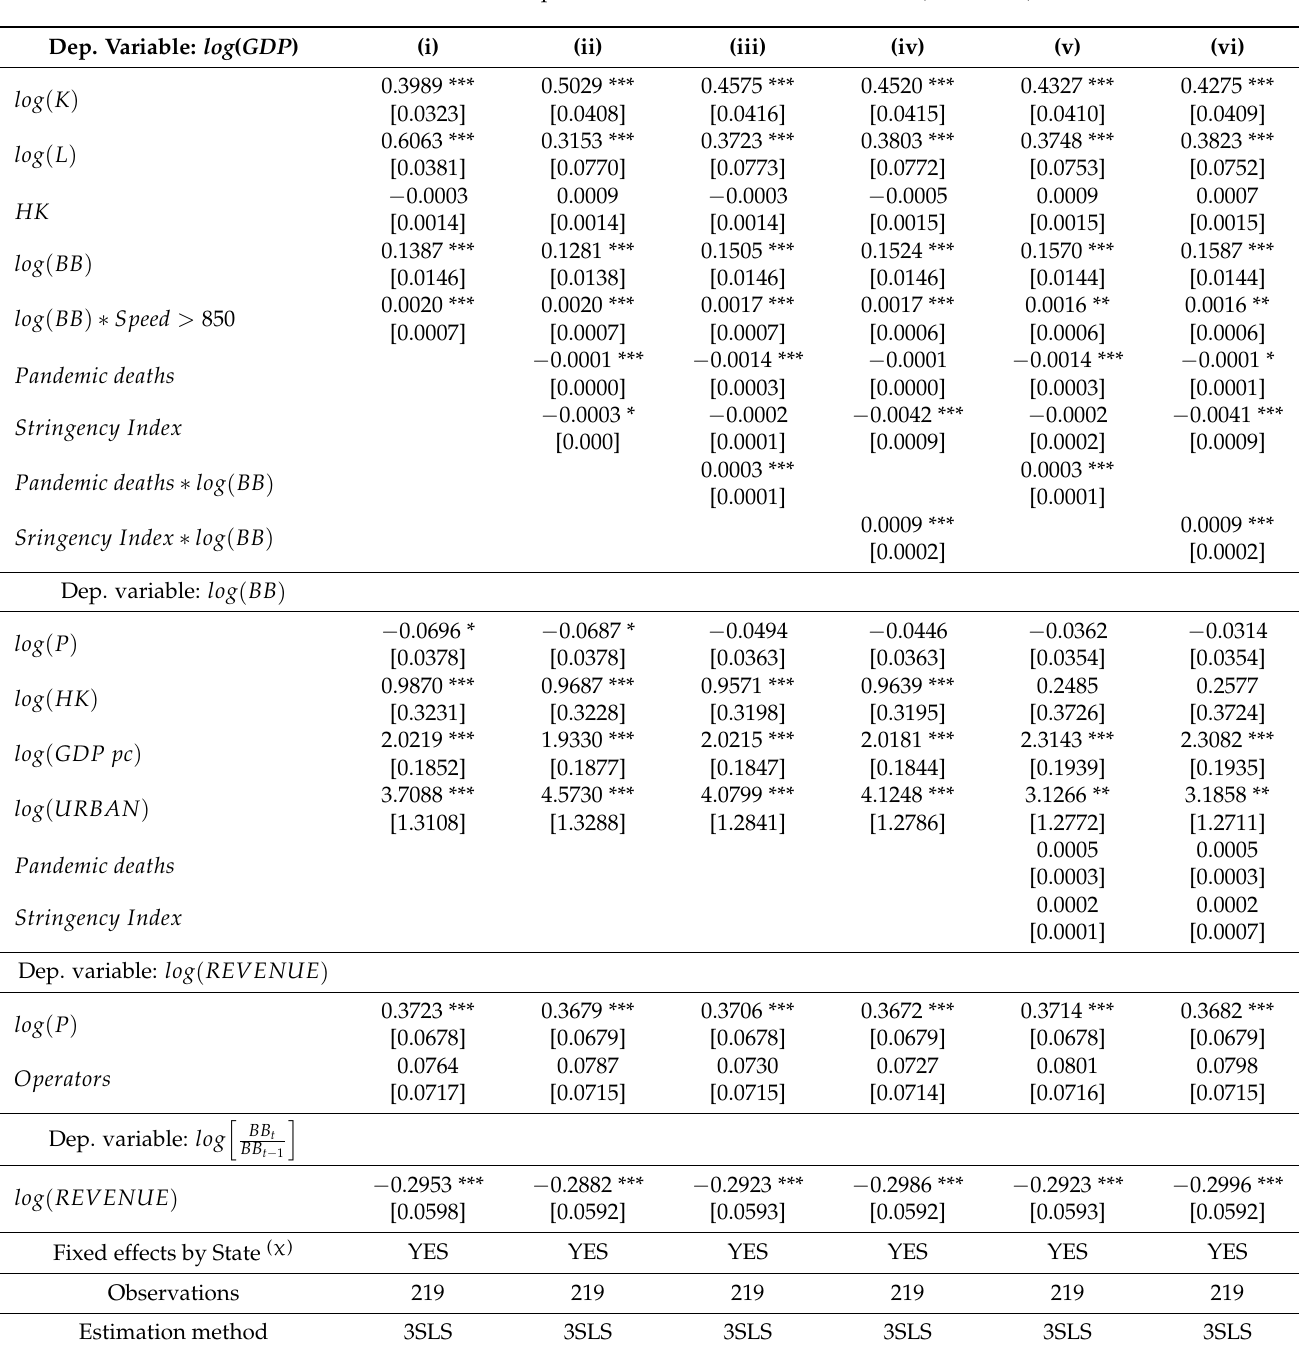
Table 4. Economic Impact of Broadband—Structural model